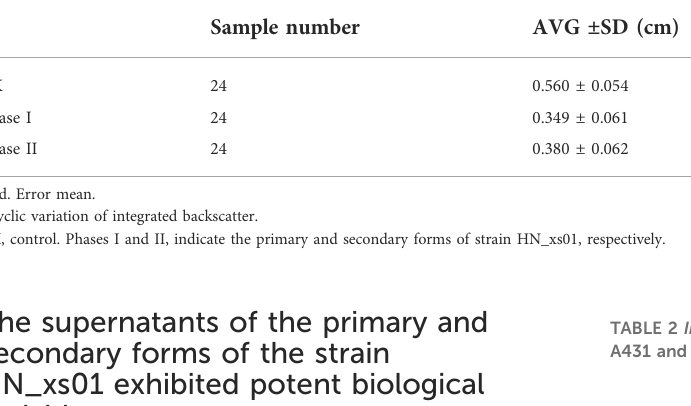
TABLE 1 Inhibition of H. armigera larval growth after 72 h-culture of different forms of strain HN_xs01.